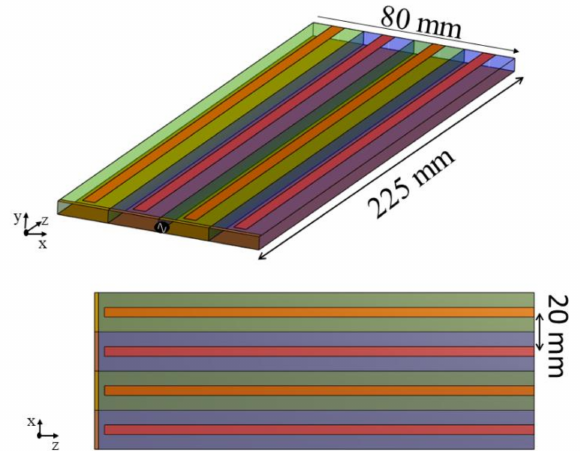
Figure 5. The proposed design of the coplanar interleaved gapped microstrips consisting of four conducting lines.